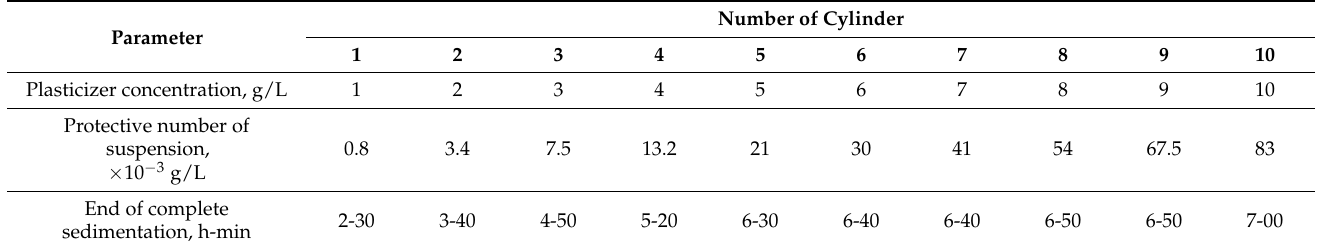
Table 11. Sedimentation stability of slag suspension without ultrasonic processing.